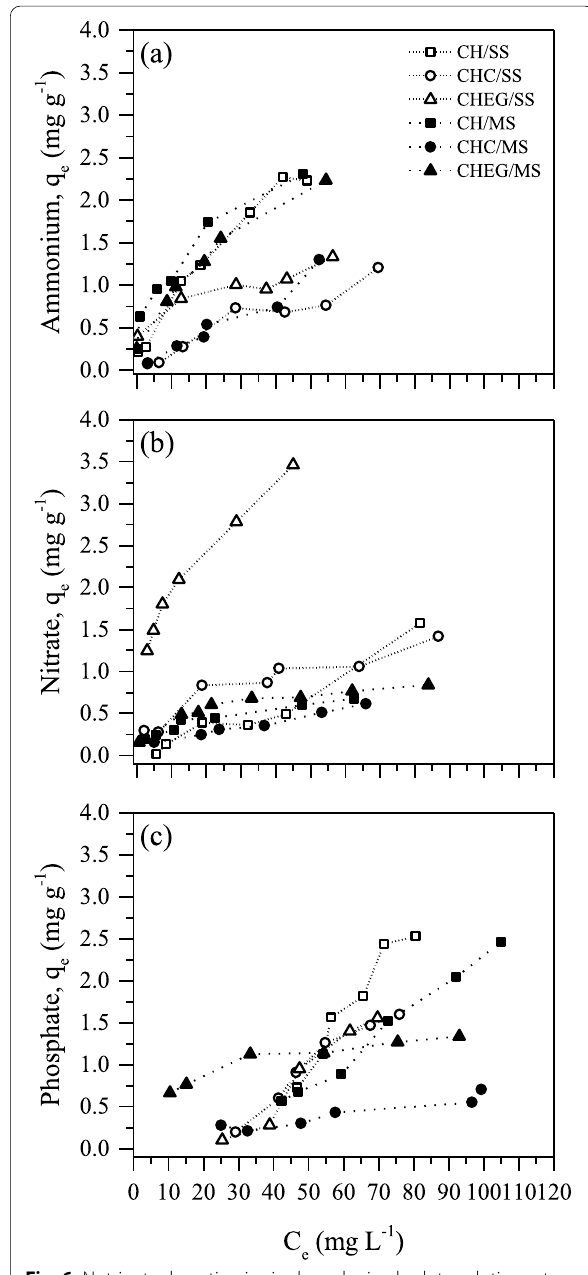
Fig. 6 Nutrient adsorption in single and mixed solute solutions at equilibrium time of 48 h; ( a ) NH 4 + , ( b ) NO 3 − and ( c ) PO 43 − (SS solute, MS mixed =